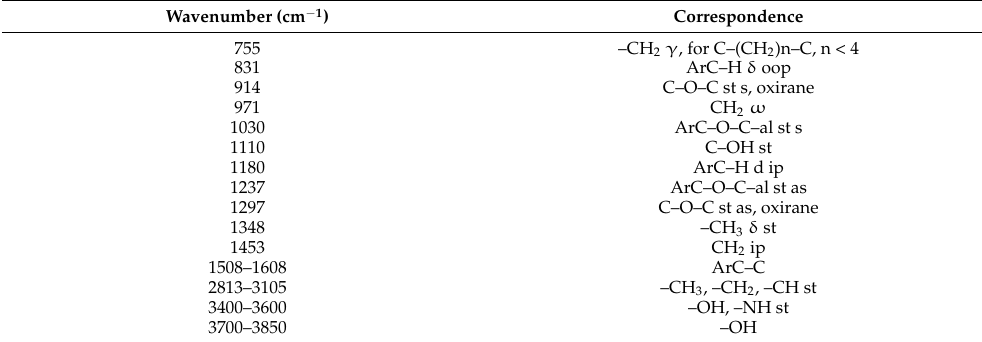
Figure 6. Infrared spectra of components A and B, and epoxy resin before curing, after curing, and after post-curing. Table 5. Correspondences of the most characteristic infrared bands of the spectrum, adapt [48]. Reproduced with permission from authors.